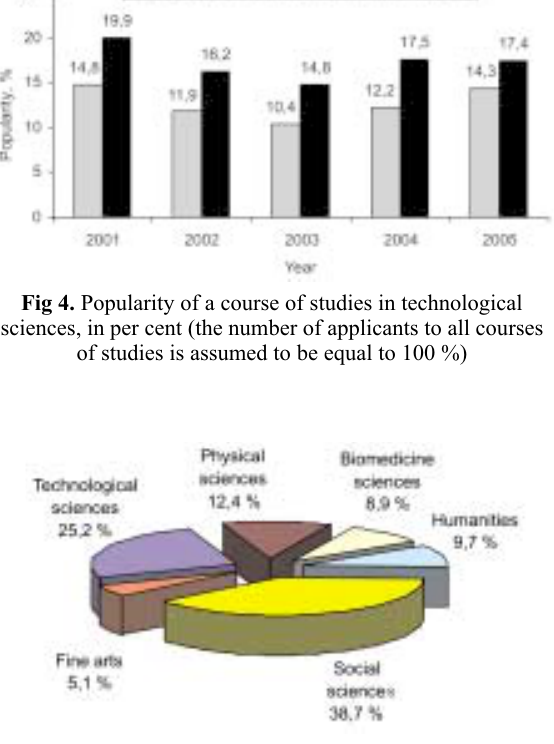
Fig 5. Distribution of state-fixed quotas of students at higher schools in 2005 according to the fields of